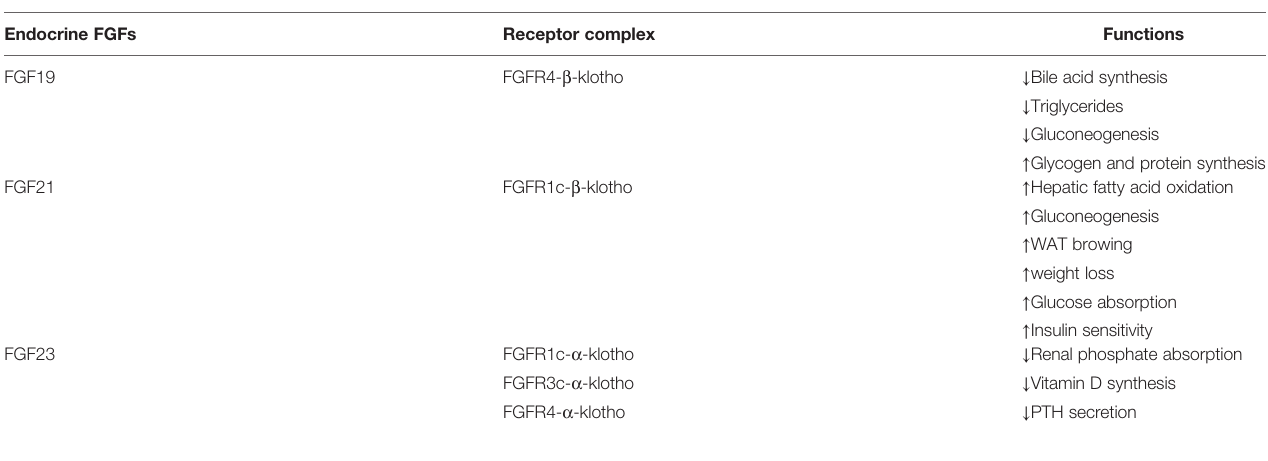
TABLE 1 | Endocrine FGF physiological function. Endocrine